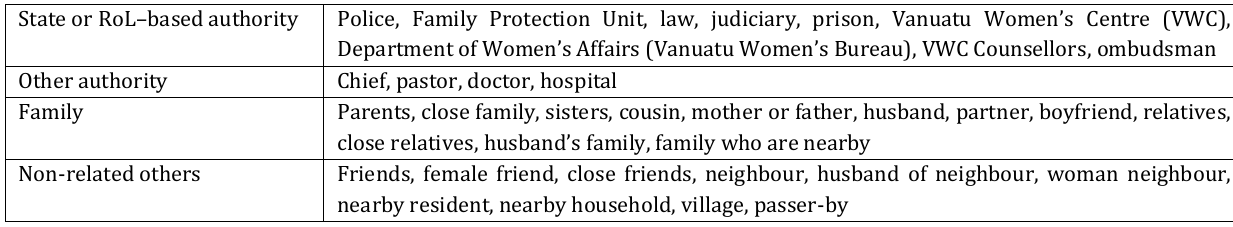
Table 2: Who could help women who are vulnerable to violence? State or RoL – based authority